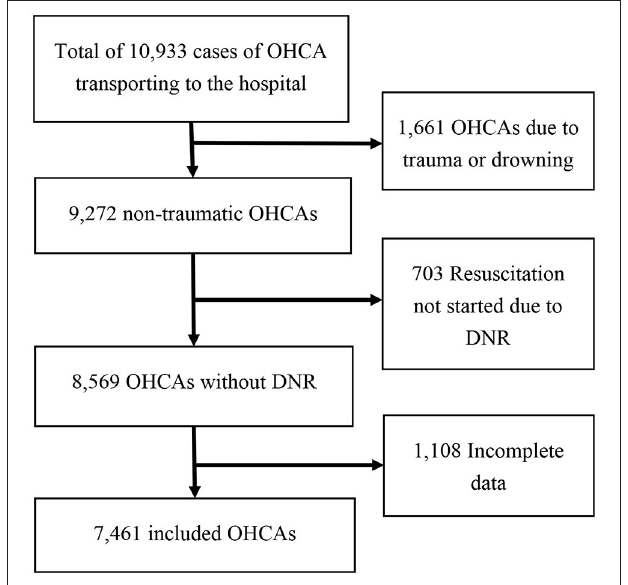
FIGURE 1 | Flow chart of patient disposition in this study. OHCA, out-of-hospital cardiac arrest; DNR, do not resuscitate order.